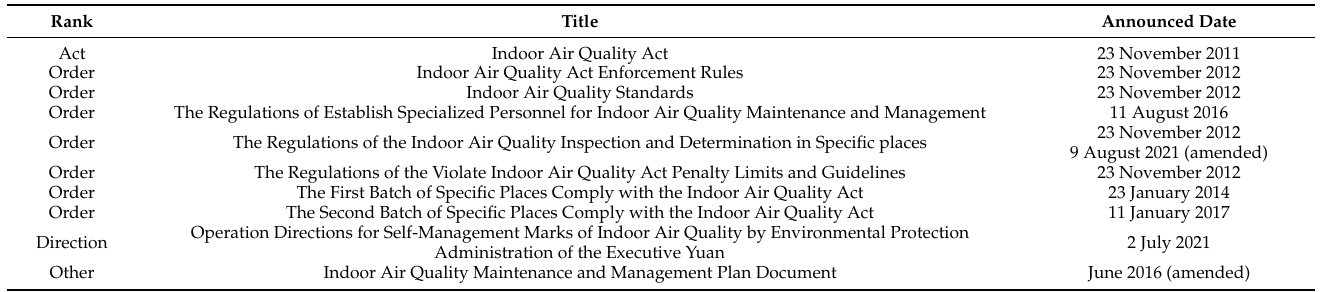
Table 2. IAQ regulations in